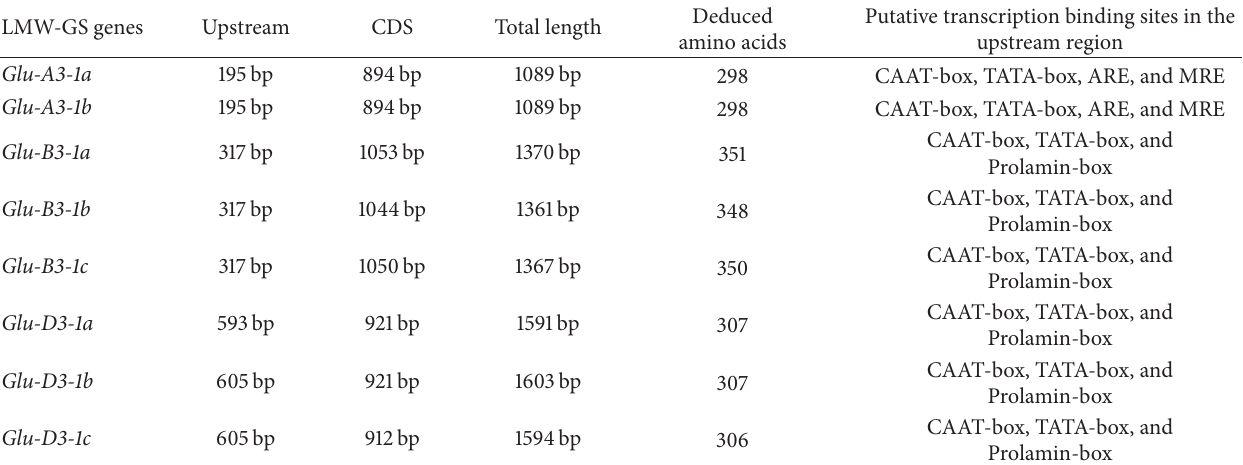
Table 1: Comparison of nucleotide sequences of the eight cloned